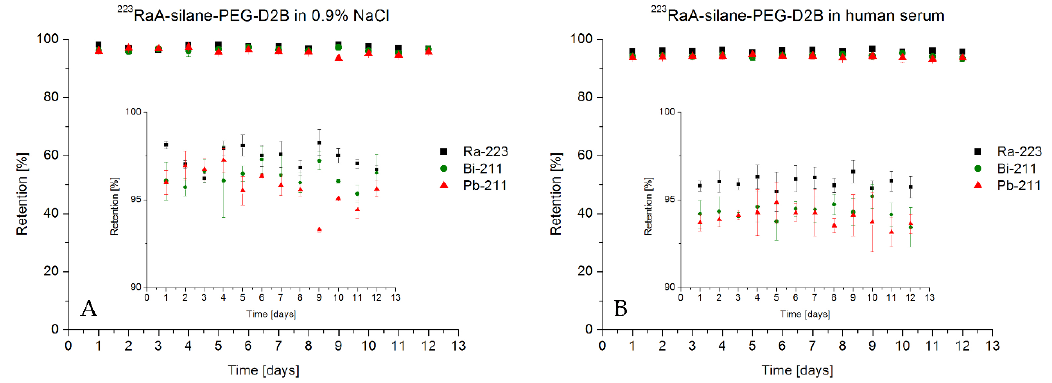
Figure 6. Retention of 223 Ra, 211 Bi, and 211 Pb on NaA-silane-PEG-D2B product radiolabeled with 223 Ra in ( A ) 0.9% NaCl and ( B ) and human blood. Insets show the values of retention from 90% to 100%. Stability was determined in 100 µL of 223 RaA-silane-PEG-D2B, which represented 100 µg/mL and 0.065 MBq.